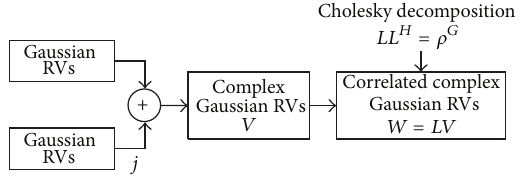
used to generate correlated taps with arbitrary amplitude and phase correlation coefficients, fading parameters, and energy parameters.